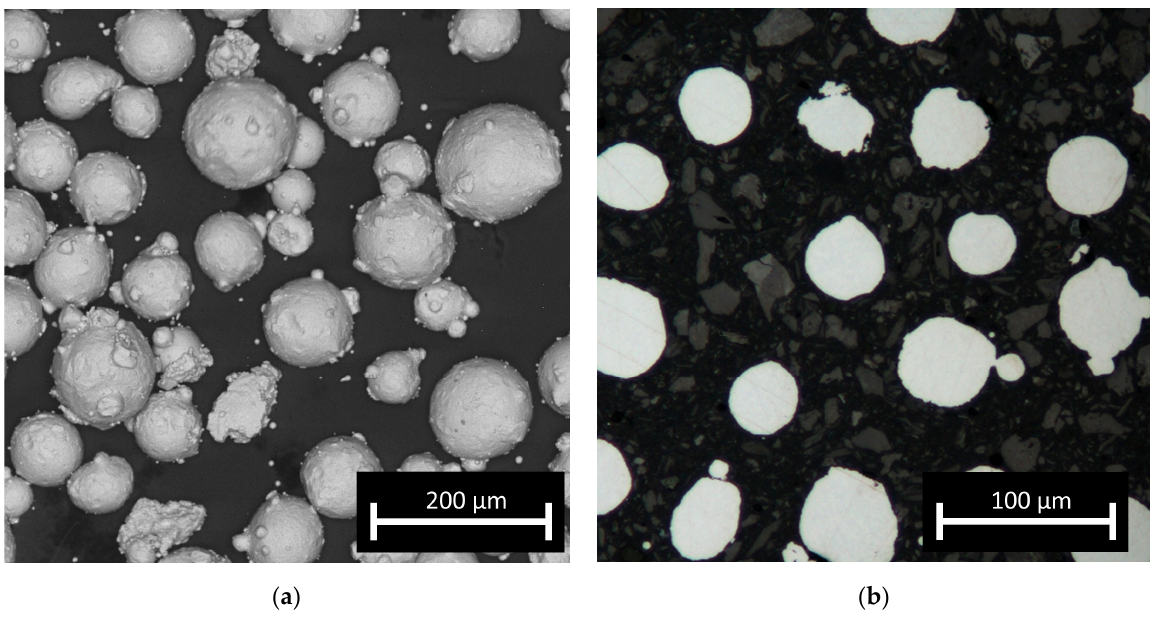
Figure 1. Micrographs of feedstock powder: ( a ) optical microscopy image of particles and ( b ) SEM image of powder showing its morphology.